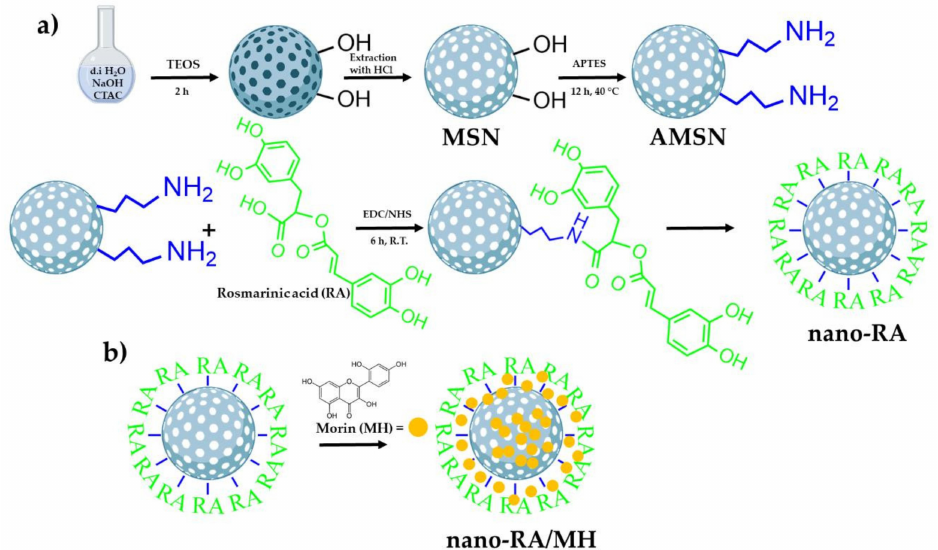
Figure 10. Schematic representation of the preparation of morin-loaded nanoantioxidants (nano- RA/MH). ( a ) Schematic path to obtain the antioxidant nanocarrier (nano-RA) and ( b ) schematic representation of the loading of morin in the nano-RA (nano-RA/MH) (adapted from Arriagada et al. [158], copyright 2020